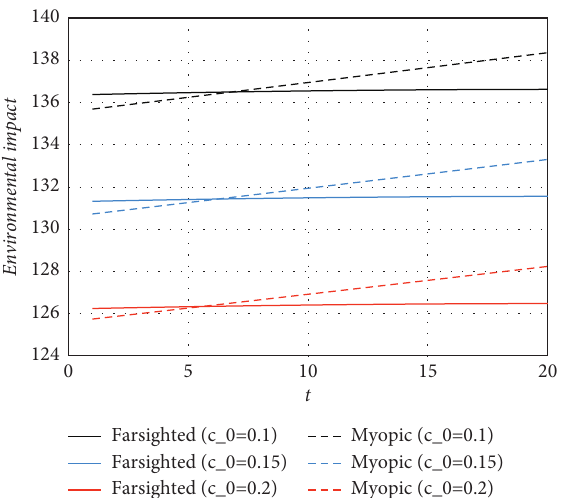
Figure 4: Impact of initial value of unit production cost on environment.